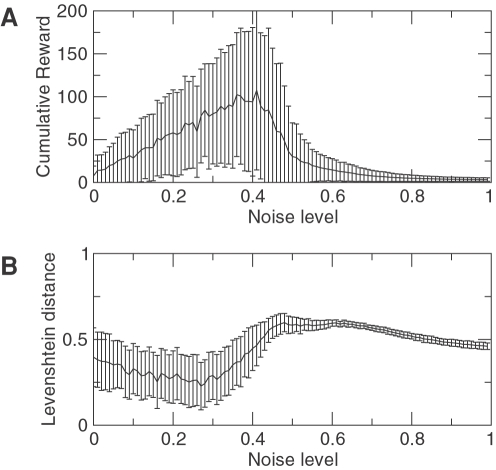
Estimation of the cumulative reward for different noise levels using multiplicative noise.(A) Cumulative reward calculated as the number of cognitive states that the system travels through until the final time of the game T* which is 100 in this case. For each level of noise, 1000 different sequences are generated (for N = 15 and a total of 15 choices). (B) Reproducibility index of the sequence calculated with the average Levenshtein distance across all generated sequences. The lower the distance, the more similar the sequences are for 1000 different runs. The pair distances are calculated and averaged to obtain the mean and the standard deviation which is represented by the error bars.